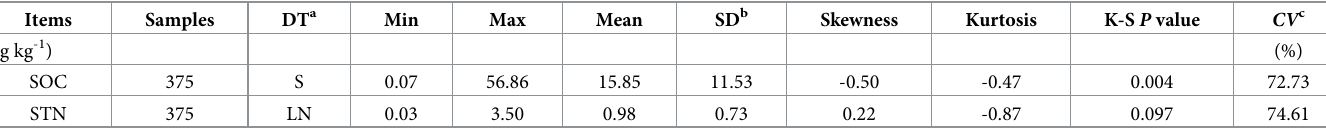
Table 1. Descriptive statistics of SOC and STN in topsoil.